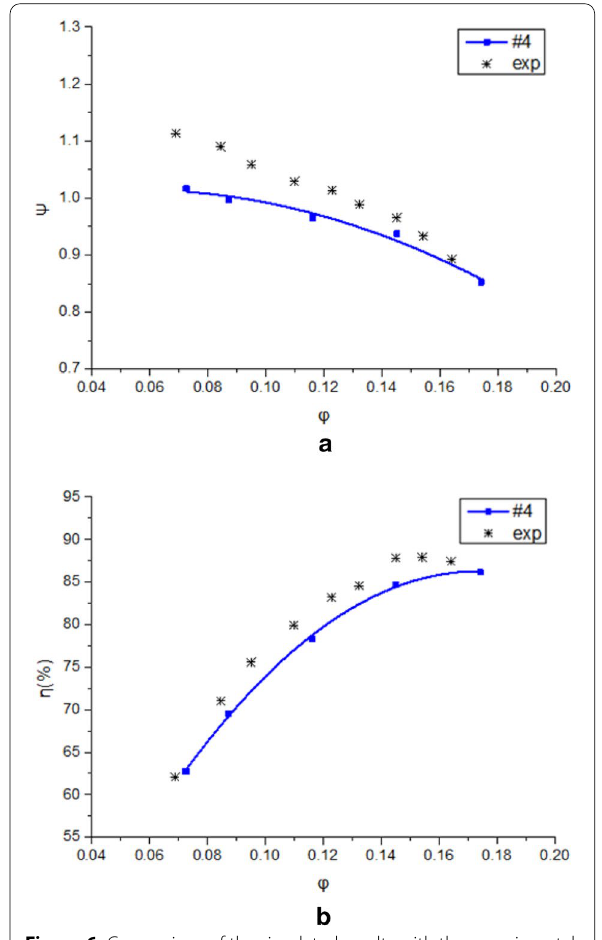
Figure 6 Comparison of the simulated results with the experimental data for model #4: a Dimensionless head coefficient; b Efficiency